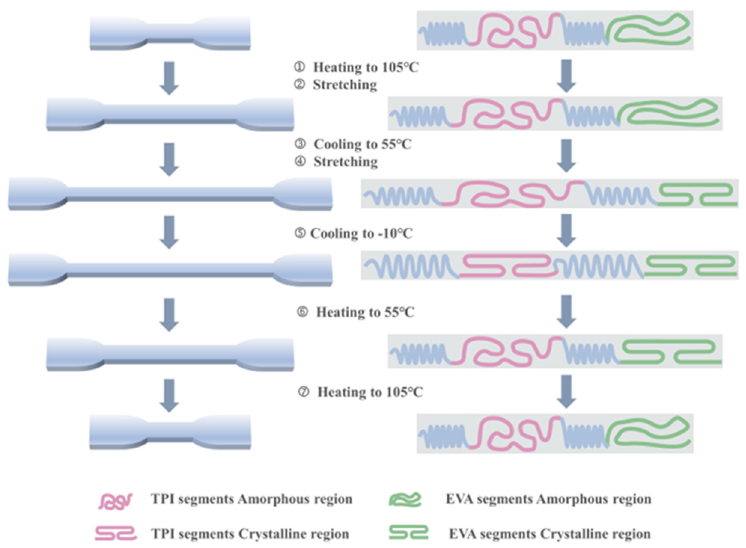
Scheme 2. Schematic diagram of TPI/EVA composites in triple shape memory